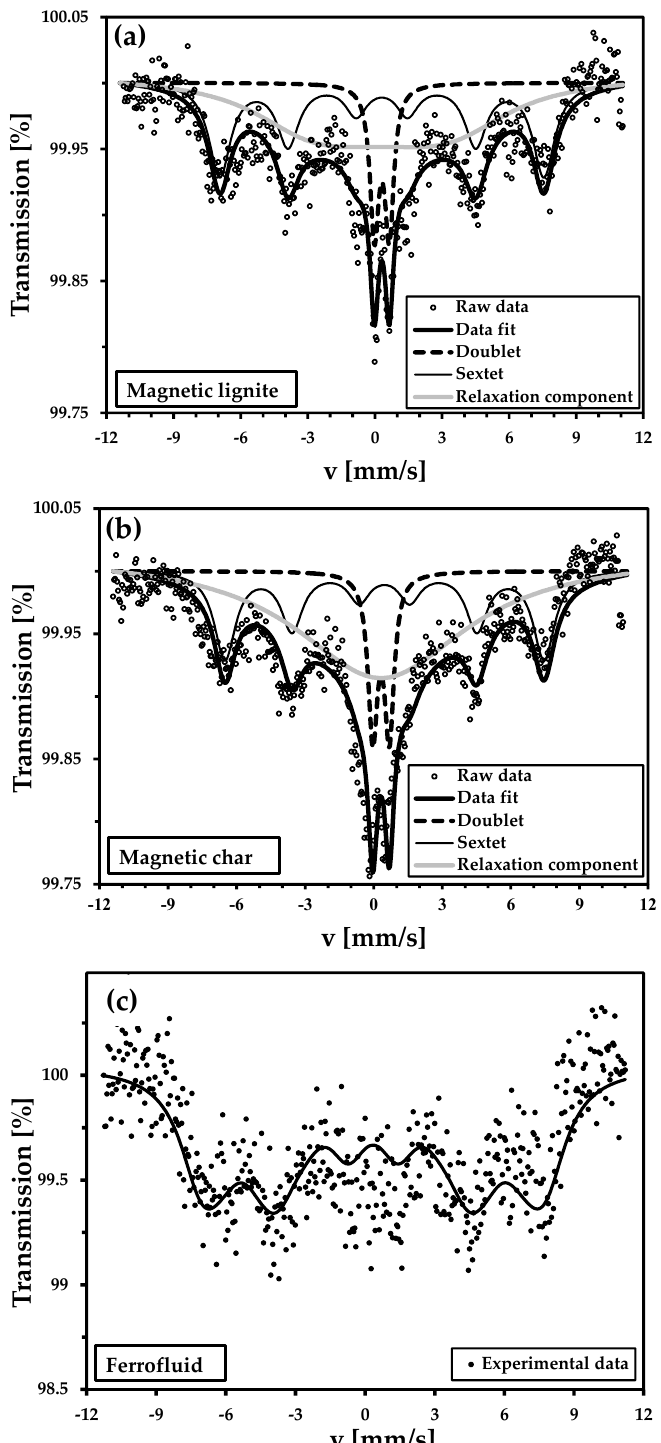
Figure 5. Room-temperature 57 Fe Mössbauer spectra of the magnetic lignite ( a ), magnetic char ( b ), and dried ferrofluid ( c ).